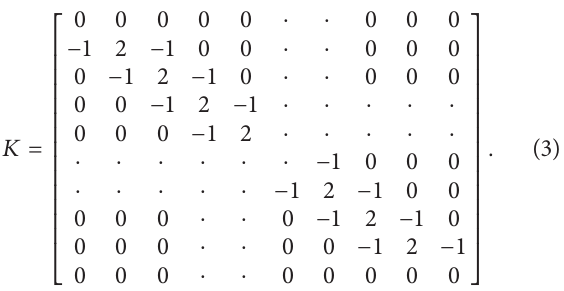
sand blowing, and sandstorm [2]. In2006 Liu and Niu used a CE-318 sun photometer to retrieve the AOD and size distribution by extinction method in Inner Mongolia and the results show that there were significant variations in temporal special distributions of AOD [1]. In 2010 Mao et al. used a compact Mie scattering lidar system for the first time to measure the optical properties and temporal-spatial distribution of atmospheric aerosol particles from 1 to 10 April over Yinchuan area